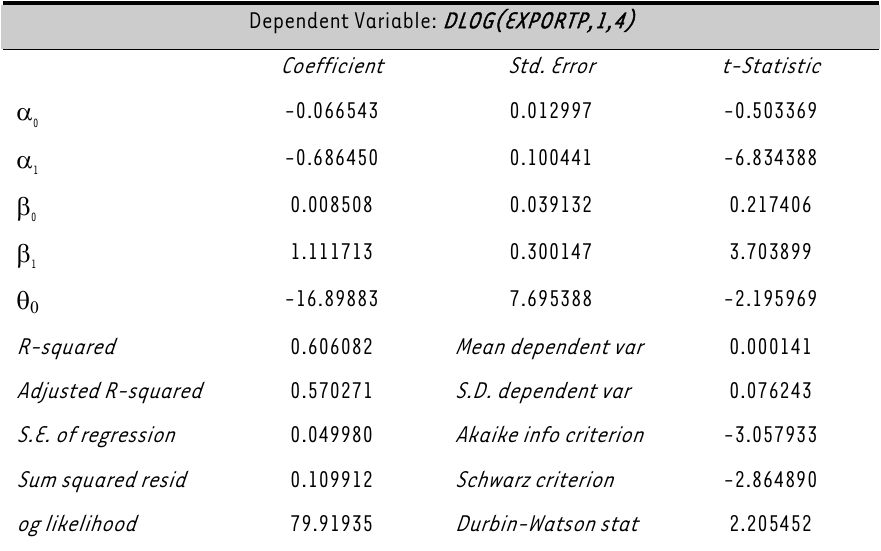
TABLE 7: Results of the LSTAR Model for EXPORTP Dependent Variable: DLOG(EXPORTP,1,4) Std.